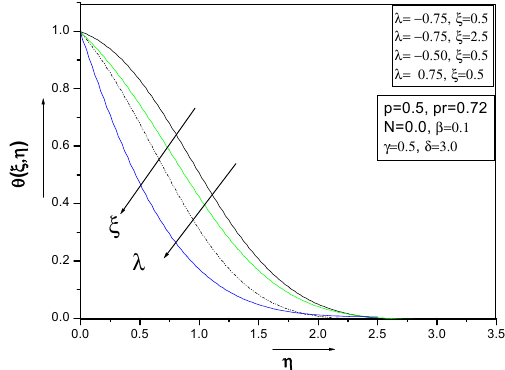
Figure 7. Effect of the temperature exponent parameter on temperature profile.